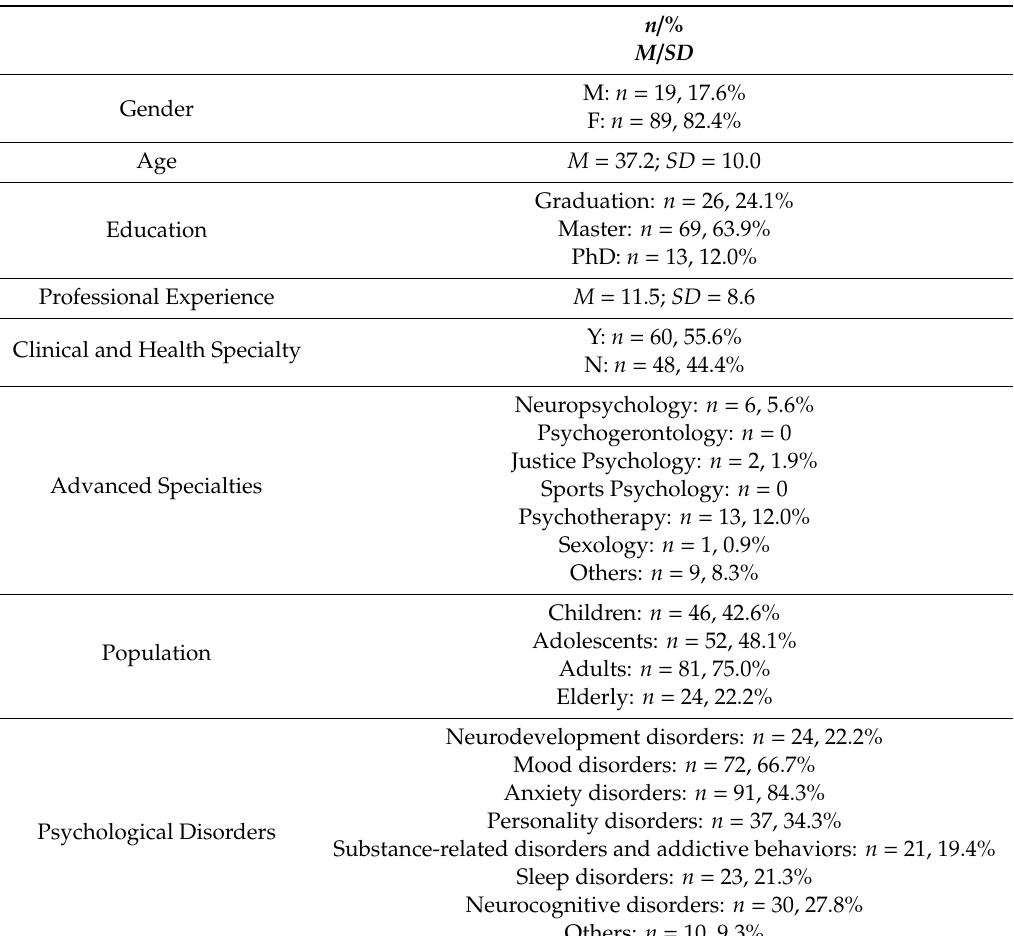
Table 1. Socio-demographic characteristics of the